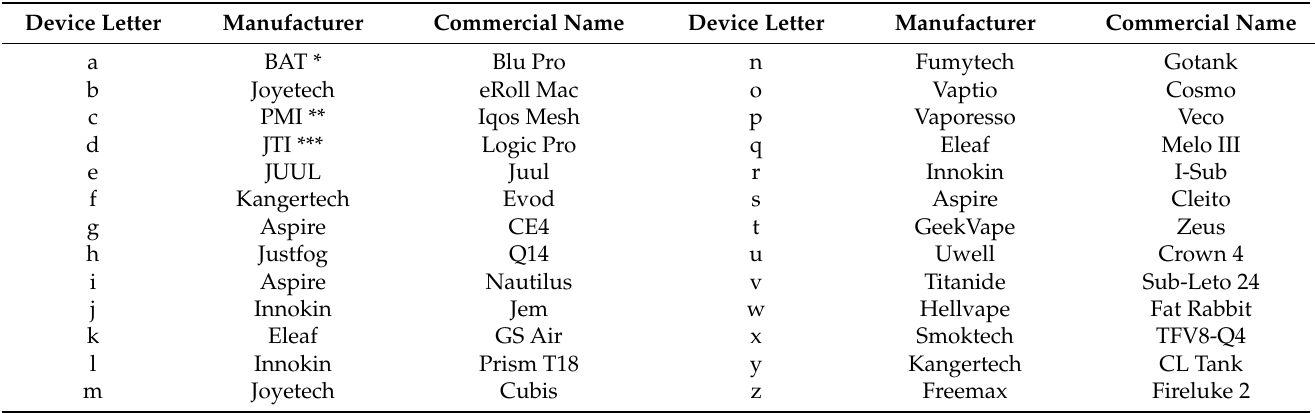
Table 1. List of the twenty-six tested devices.